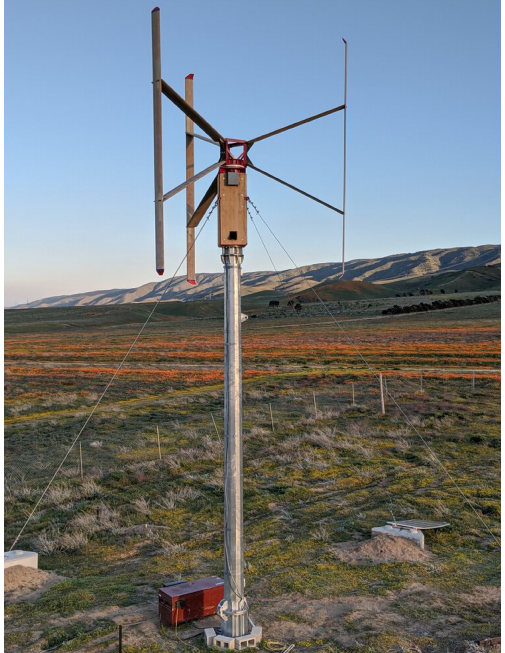
Figure 9. XFlow’s 5kW prototype VAWT at the Field Laboratory for Optimized Wind Energy in Lancaster, California.